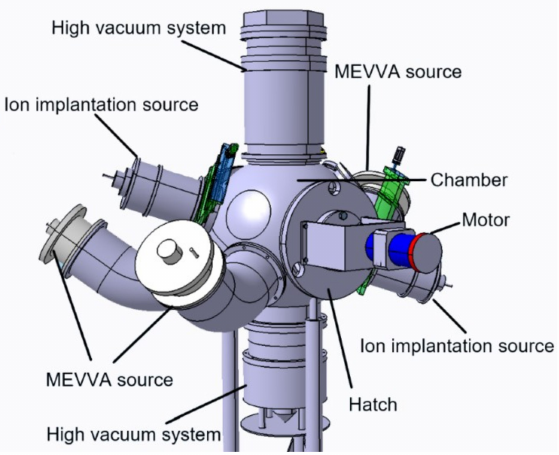
Figure 2. The 3-D model of MFCVA setup.